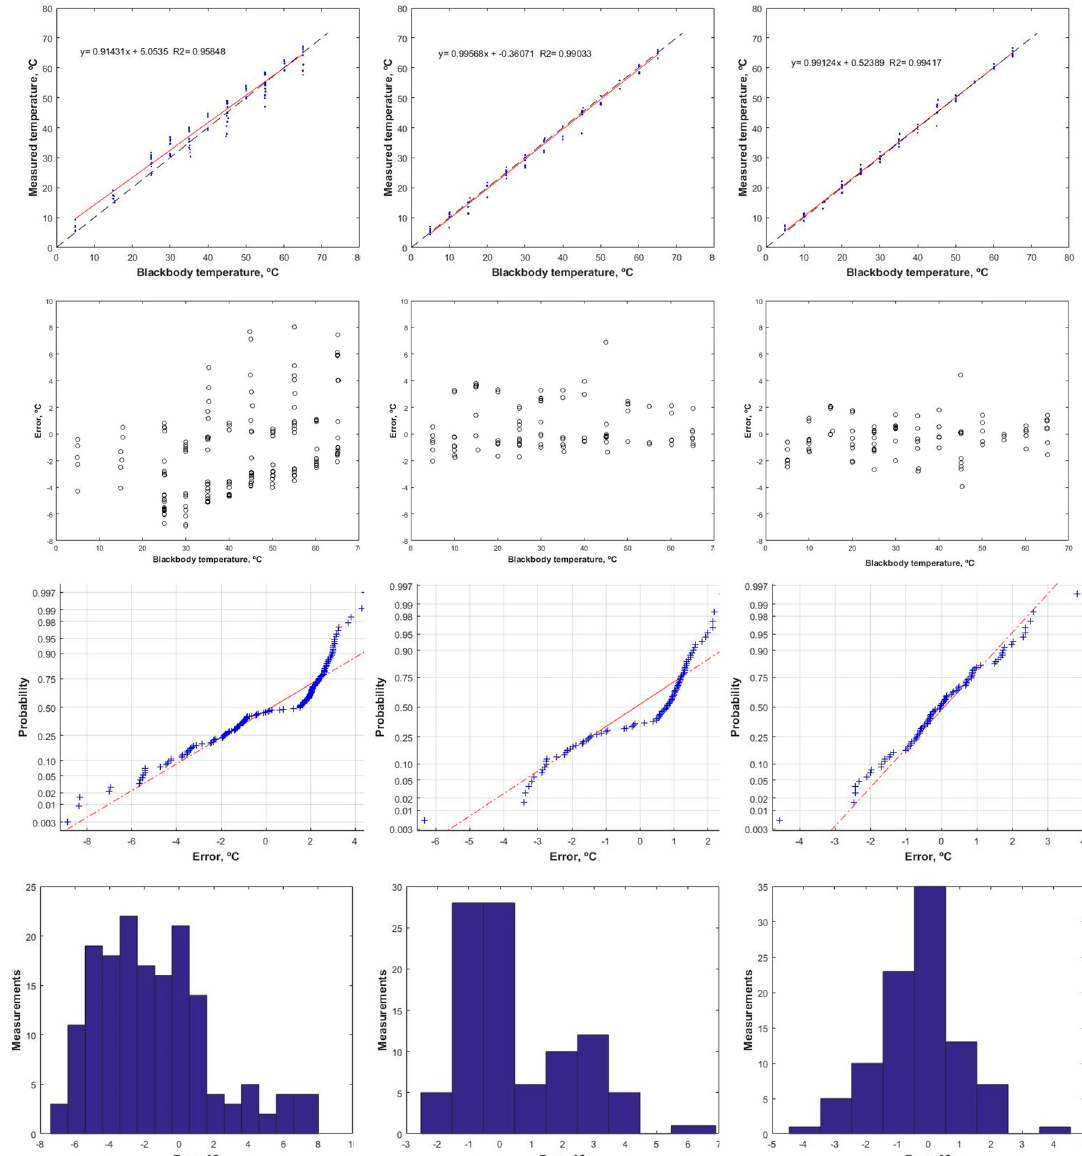
Figure 7. Error analysis for the FLIR Tau2 9 mm camera with the original configuration (column 1),